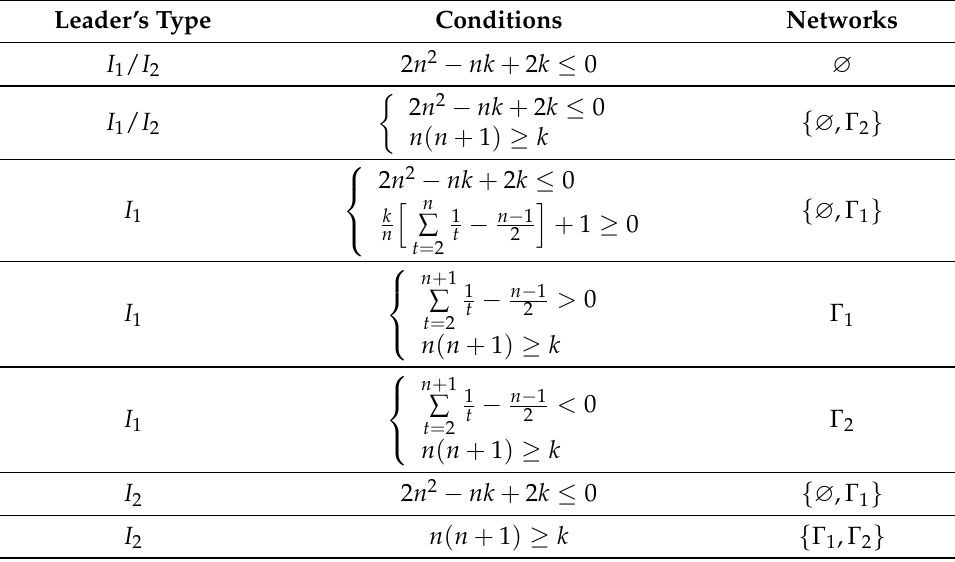
Table 5. Summary of the results with θ i ( Γ , I 1 ) = n i ( Γ ) / ( n − 1 ) . Leader’s